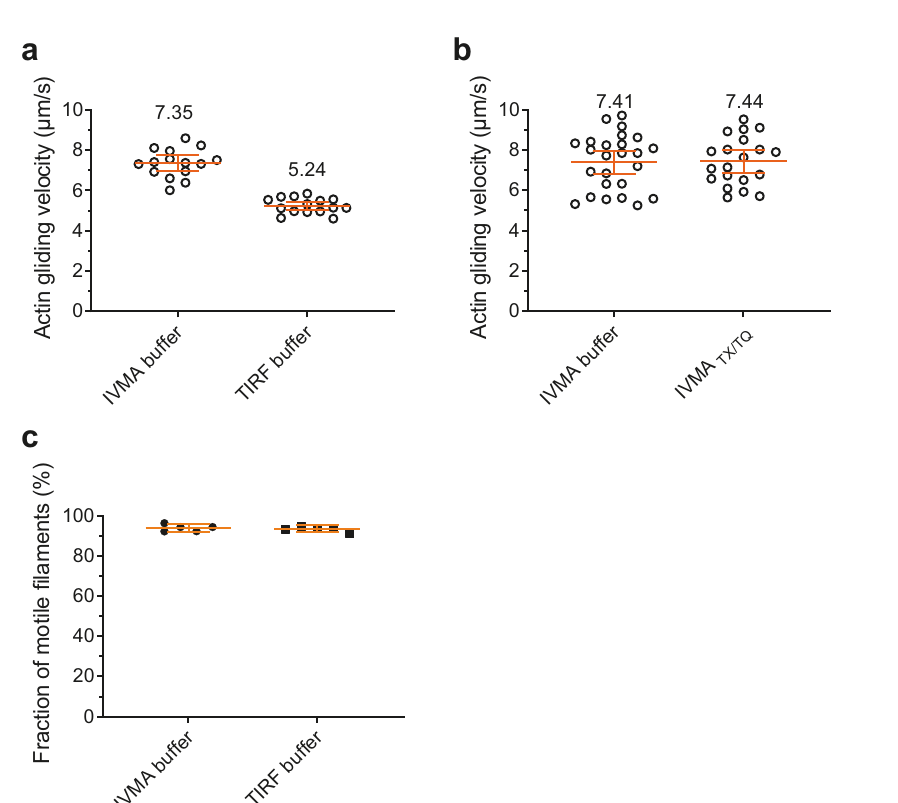
Fig. 3 Analysis of motility in standard IVMA buffer and optimized TIRF buffer. a Actin gliding velocity produced by HMM adsorbed to TMCS derivatized glass surfaces. In each individual experiment, 15 actin fi laments were analyzed. b Actin gliding velocity produced by HMM adsorbed to TMCS derivatized glass surfaces. In each individual experiment, 25 (IVMA buffer) and 20 (IVMA buffer with TX/TQ) actin fi laments were analyzed. c Fraction of motile fi laments from the experiments under a , analyzed from fi ve recordings of, in total, 1004 fi laments (IVMA buffer) and 925 fi laments (TIRF buffer), respectively. Data are given as mean ± 95% con fi dence interval. Temperature 26 ± 2 °C. For details about buffer composition please see Supplementary Information sections 1.2 and